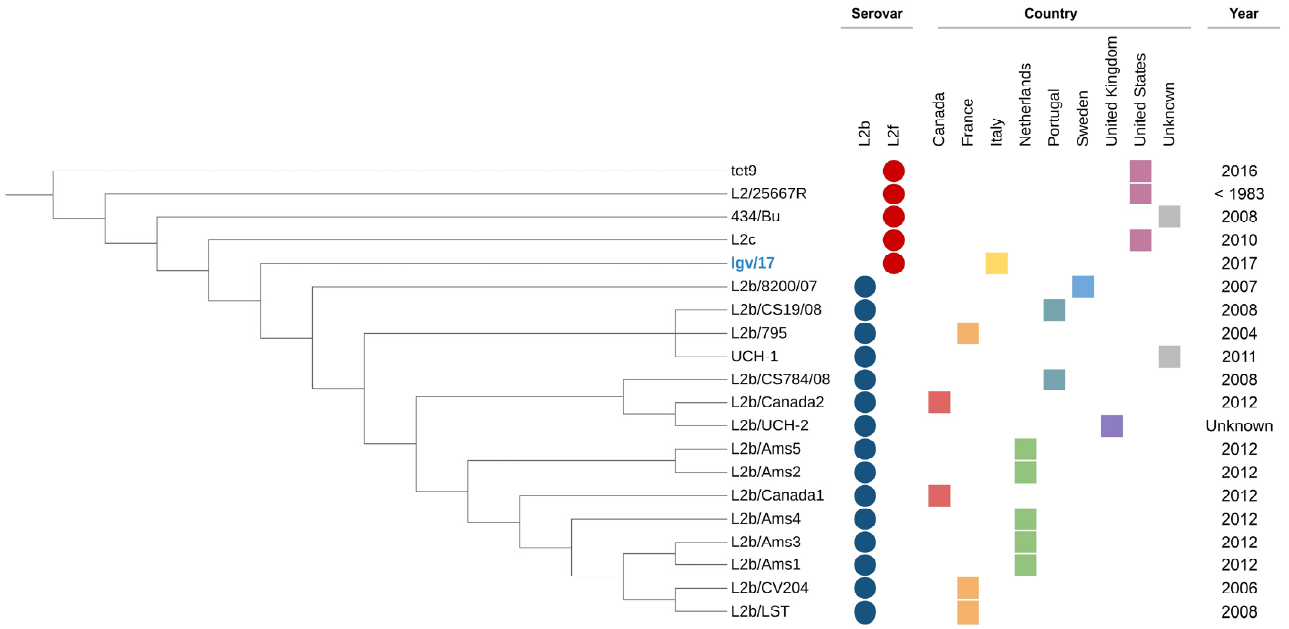
Figure 2. Phylogenetic tree annotated with metadata from each strain. Serovars are indicated by colored circles, while the countries are represented by colored squares.